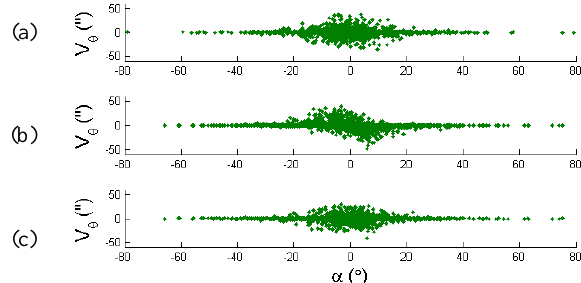
Figure 12: (a) Horizontal angle residuals versus vertical angle plot in plane-based self-calibration for hybrid scanners without systematic errors. (b) Unmodelled 1’ trunnion axis error. (c) After plane-based self-calibration.